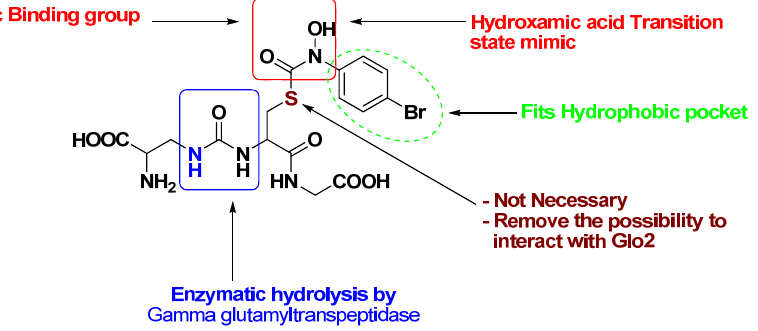
Figure 2. More et al. structural modifications to synthesize transition state competitive inhibitors of